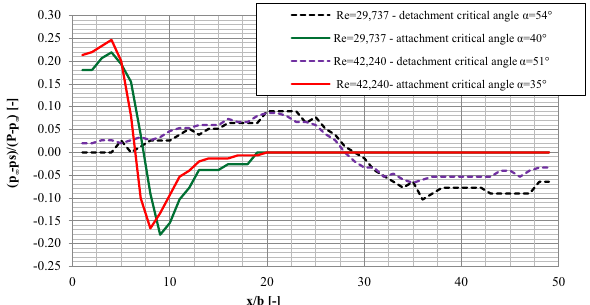
Figure 8. The comparison of the pressure distributions on the plate for critical attachment and detachment angles for selected measuring sessions with Re = 29,737 and Re = 42,240.